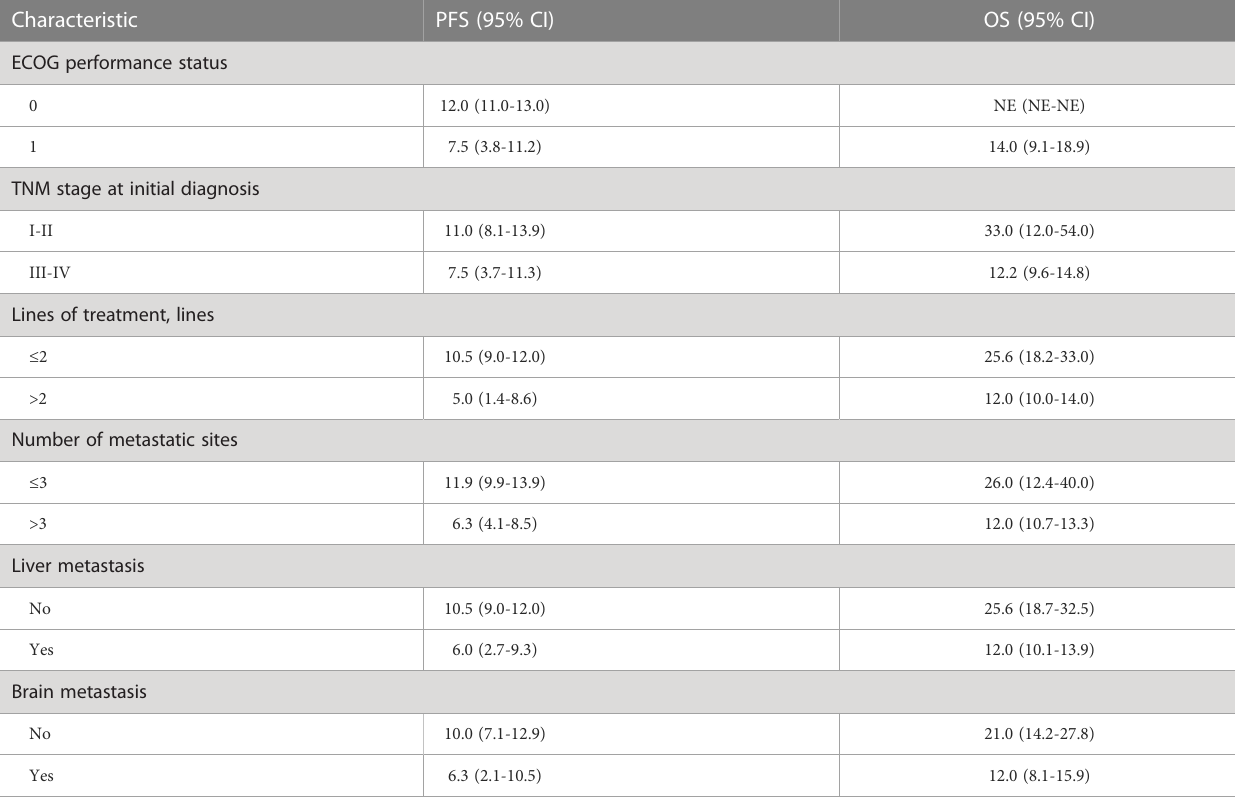
TABLE 4 PFS and OS for subgroup analysis. Characteristic